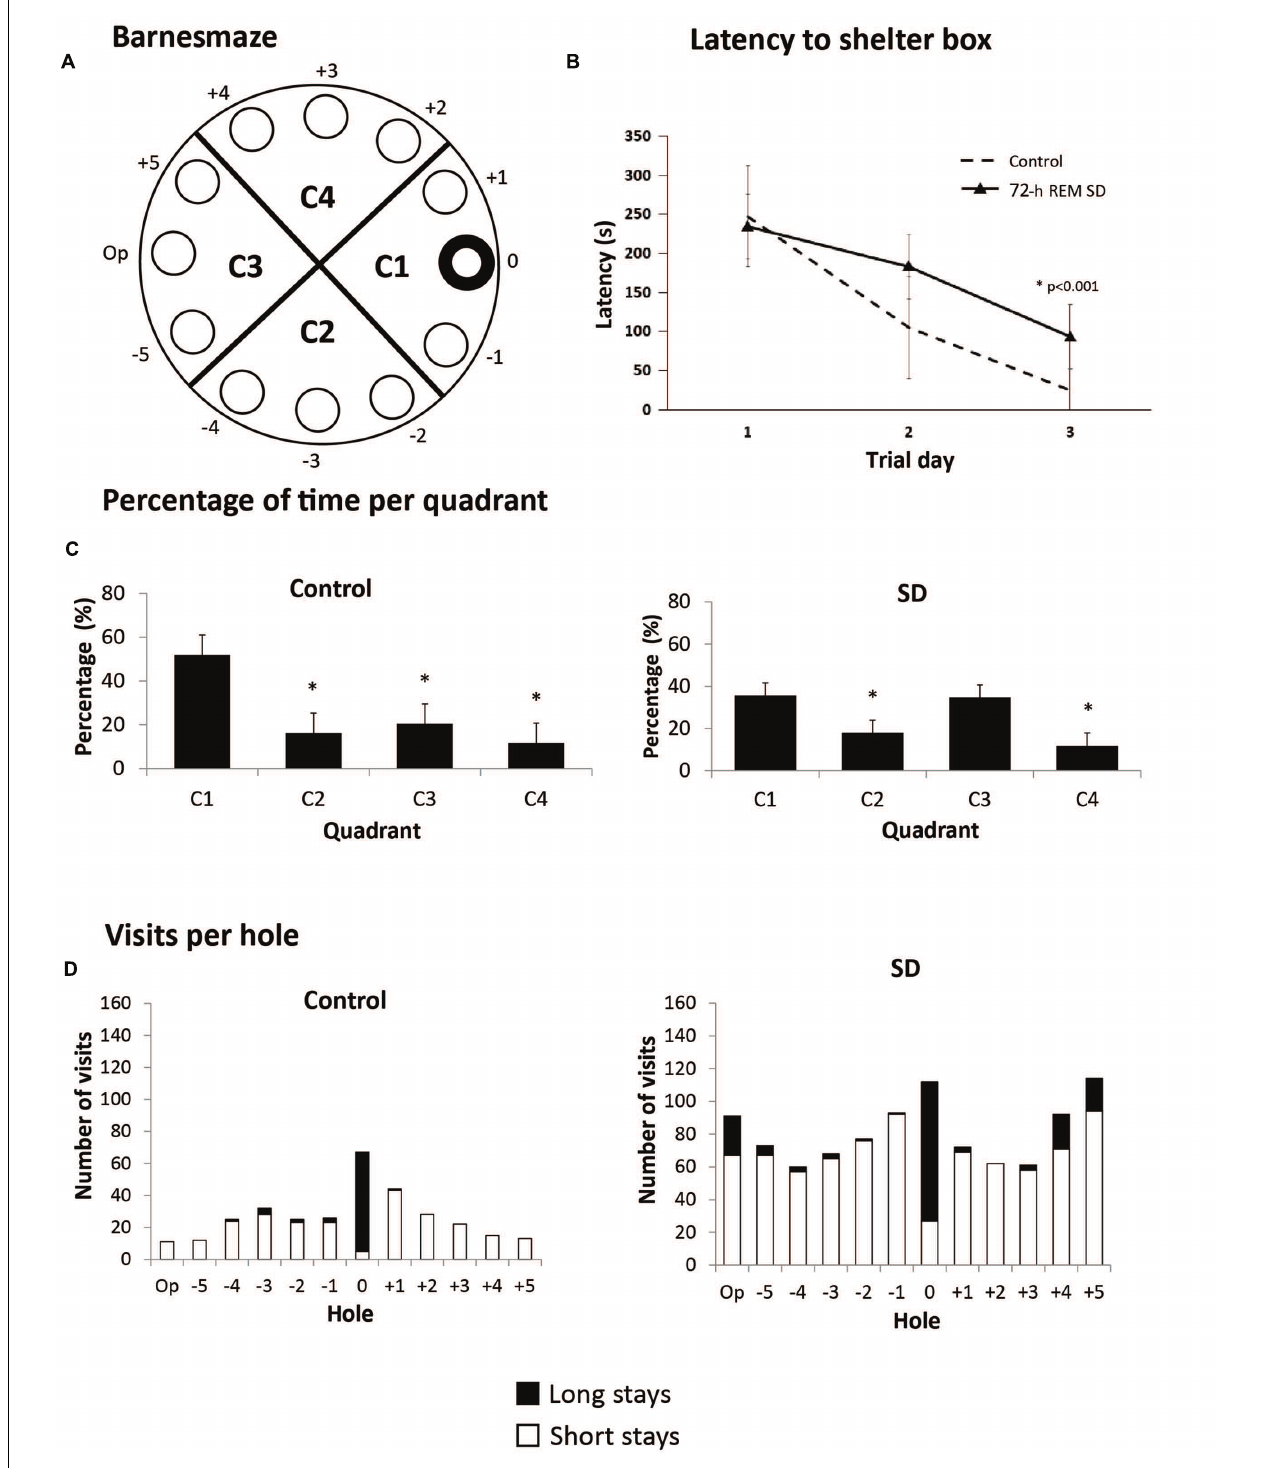
FIGURE 3 | Barnes maze. (A) Schematic representation of the Barnes maze used; hole 0 indicates shelter hole. (B) Mean latency (5 assays per day) for 3 days. (C) Percentage of time per quadrant in the 72-h REM SD group vs. controls. Bars indicate mean ± SE. ( ∗ ) Indicates a significant difference ( p < 0.05) (Mann–Whitney “ U ” test). (D) Number of visits to each hole in the last five assays. Upper part of each bar (black) represents the long visits (5 s or more), and lower part (white) are short visits (less than 5 s). Different strategies can be seen in each group according to the number of visits.